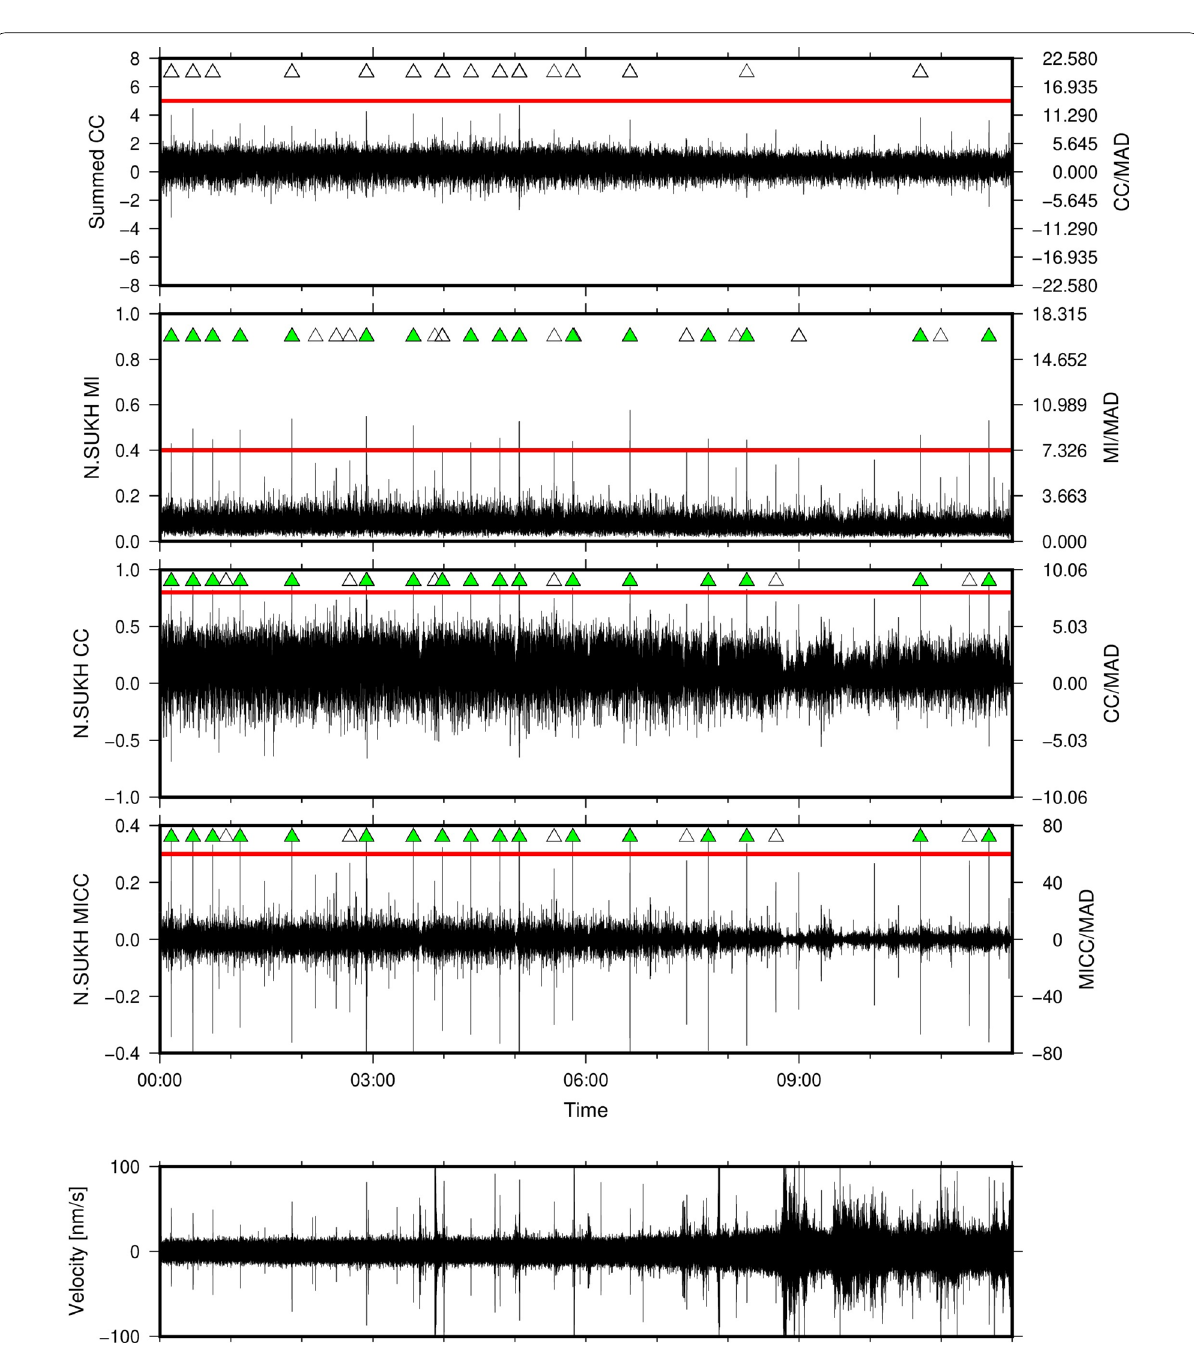
Fig. 10 Values of MI, CC, and MICC from 0:00 to 12:00 on 21 December 2010. The right axis shows each index after normalization by the MAD. The MAD is calculated using the half-day waveform data. The lowest panel shows the velocity waveform. The template earthquake is the earthquake shown in Fig. 2. Red lines show the threshold of detection. Green triangles in each panel show the detected events by the template using the index. White triangles show the detection using other templates. All of the events in this time window that were detected by the summed CC and MICC at station N.SUKH were identified as DLF earthquakes by visual